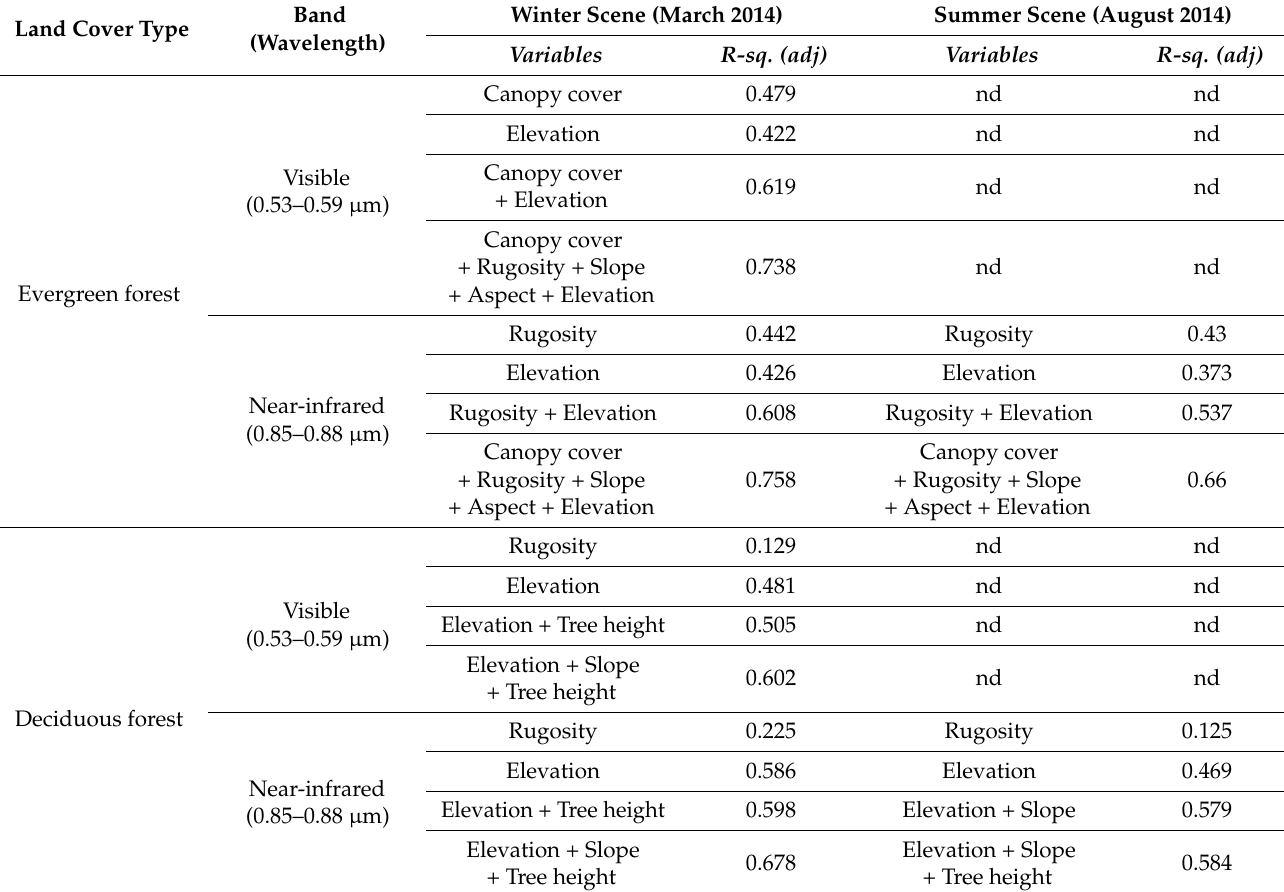
Table 1. Generalized Additive Models (GAM) of the relationships of visible and near-infrared surface reflectance with canopy structure (the variables include canopy cover, tree height, and rugosity) and topography (the variables include elevation, slope, and aspect) in March and August